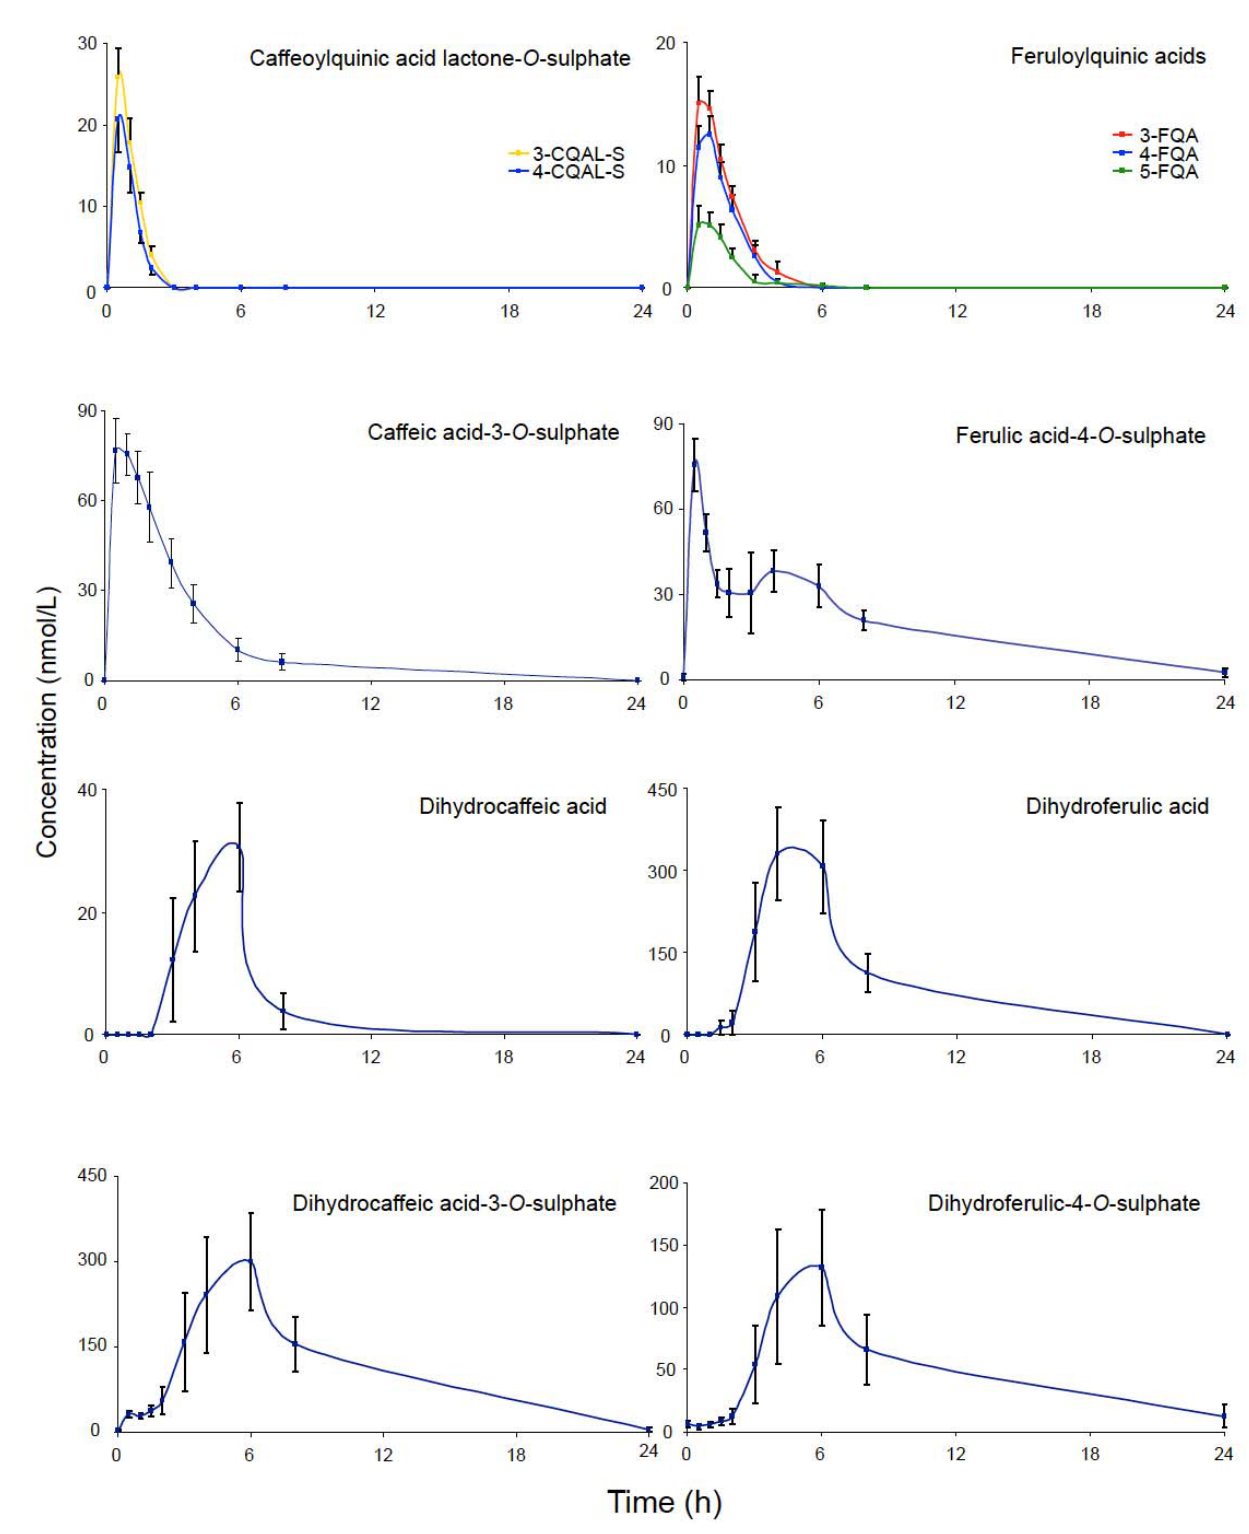
Figure 2 . Plasma pharmacokinetic profiles of circulating chlorogenic acids and metabolites, following the ingestion of 200 mL of coffee by health human